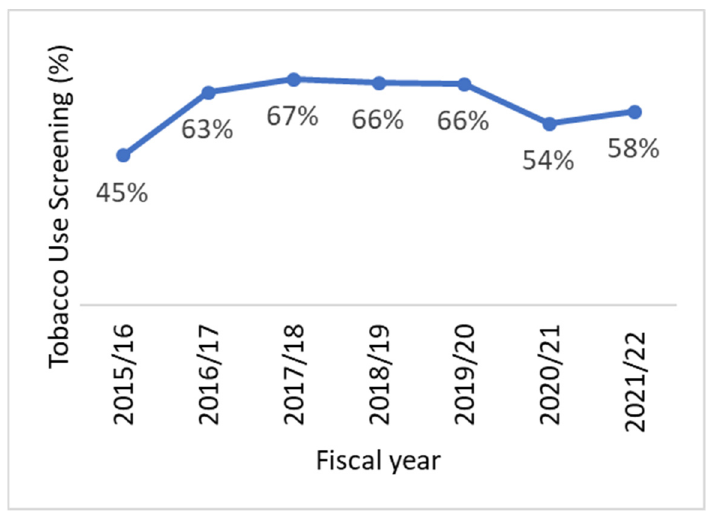
Figure 1. Tobacco use screening rates among new ambulatory cancer patients in Ontario RCCs, by fiscal year, 2015–2016 to 2021–2022.